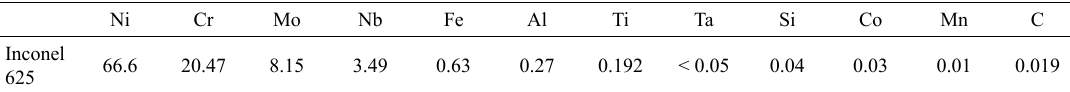
Figure 1. Dimensions of the Inconel 625 test specimens (a) tensile test (b) fatigue Table 1. Chemical composition (% by weight).